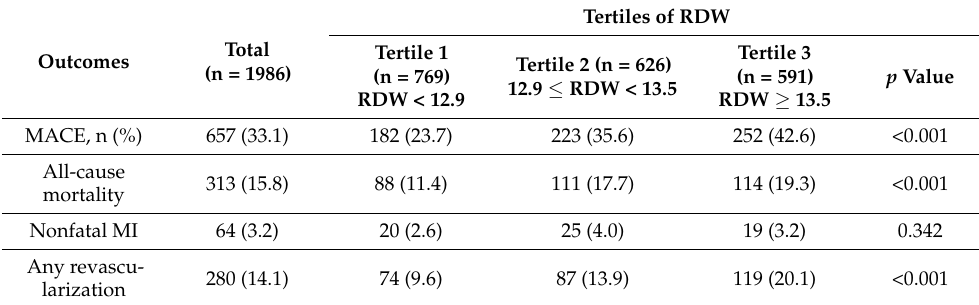
Table 2. Outcomes of patients stratified by RDW